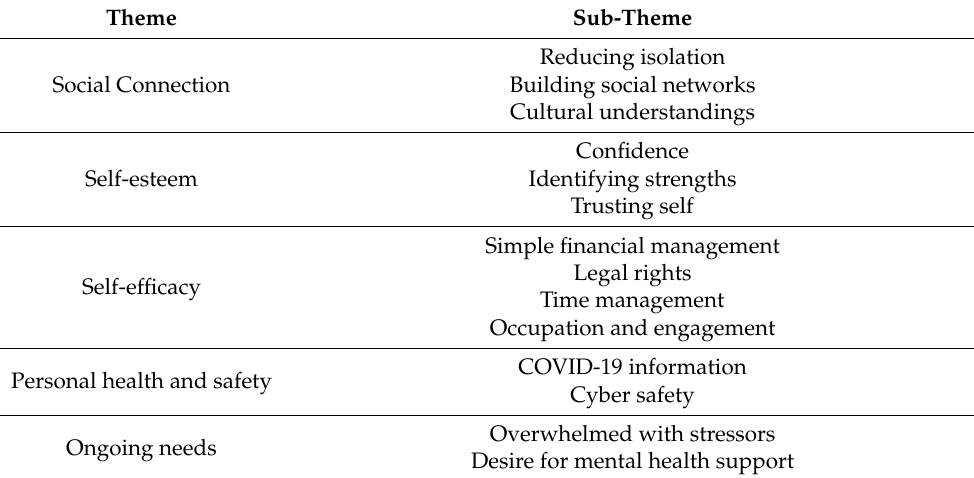
Table 3. Perceived impact of peer mentoring program on mental health of refugee and migrant women.